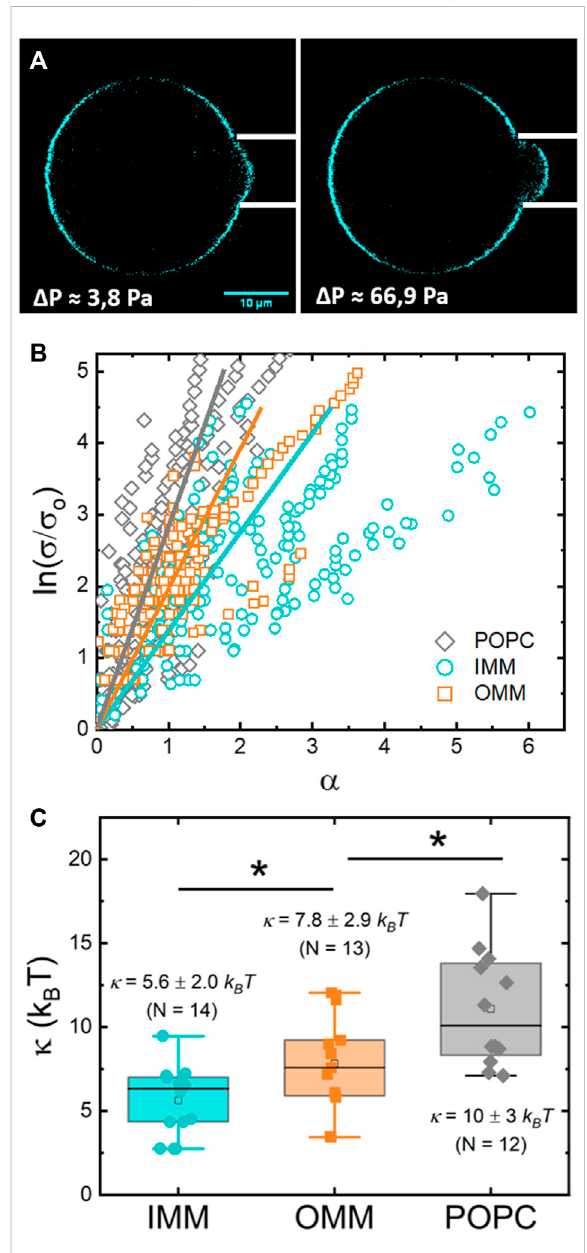
FIGURE 6 (A) Confocal micrograph of a IMM-GUV aspirated in a micropipette at low (left) and medium (right) tension. The change in the length of the protrusion is proportional to the change in the relative excess area α . (B) Plot of the logarithm of the relative tension( σ / σ 0 )versustherelativeexcessarea α fordifferentPOPC-, IMM-, and OMM-GUVs. (C) Box plots comparing the bending moduliforPOPC-,IMM-,andOMM-GUVs( N =12, N =14,and N = 13, respectively). The median is represented with a line; the box represents the 25th – 75th percentiles; and error bars show